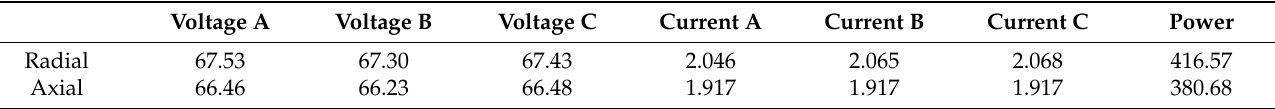
Figure 8. ( a ) Waveform of radial stator current; ( b ) Waveform of axial stator current. Table 3. RMS Voltage (V) and Current (A) value and Power (W) of two-stator motor’s winding (steady-state).